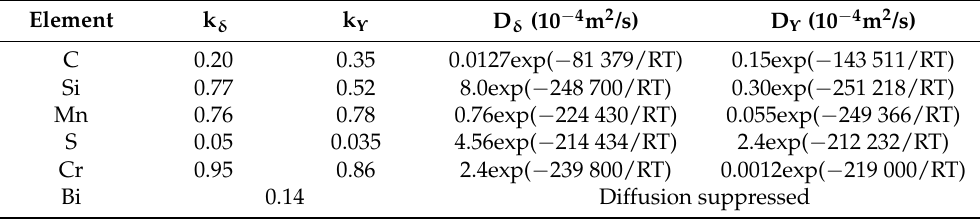
Table 3. Equilibrium partition coefficients of elements and temperature dependences of diffusion coefficients. Element